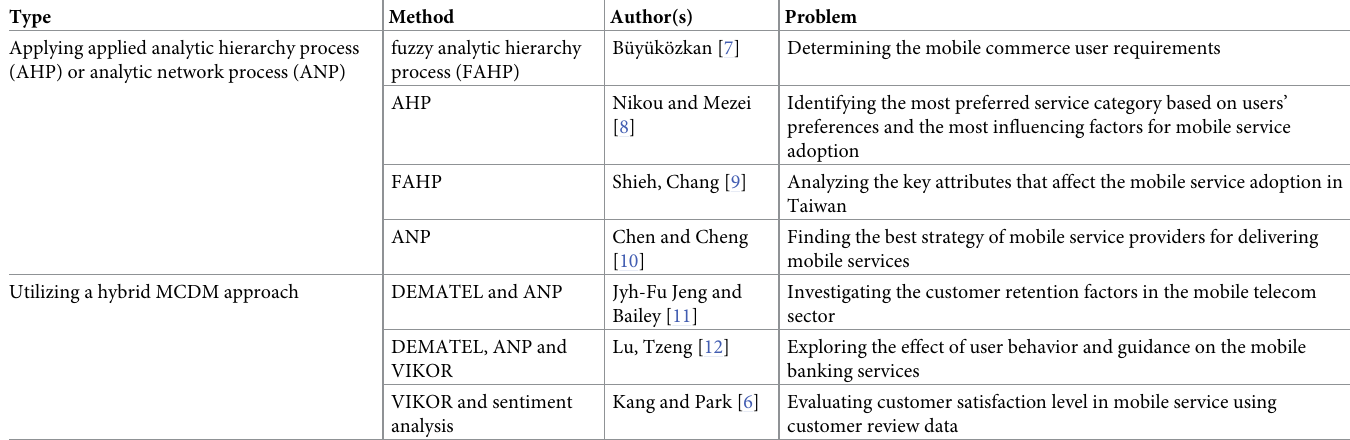
Table 1. Application of MCDM methods for the different